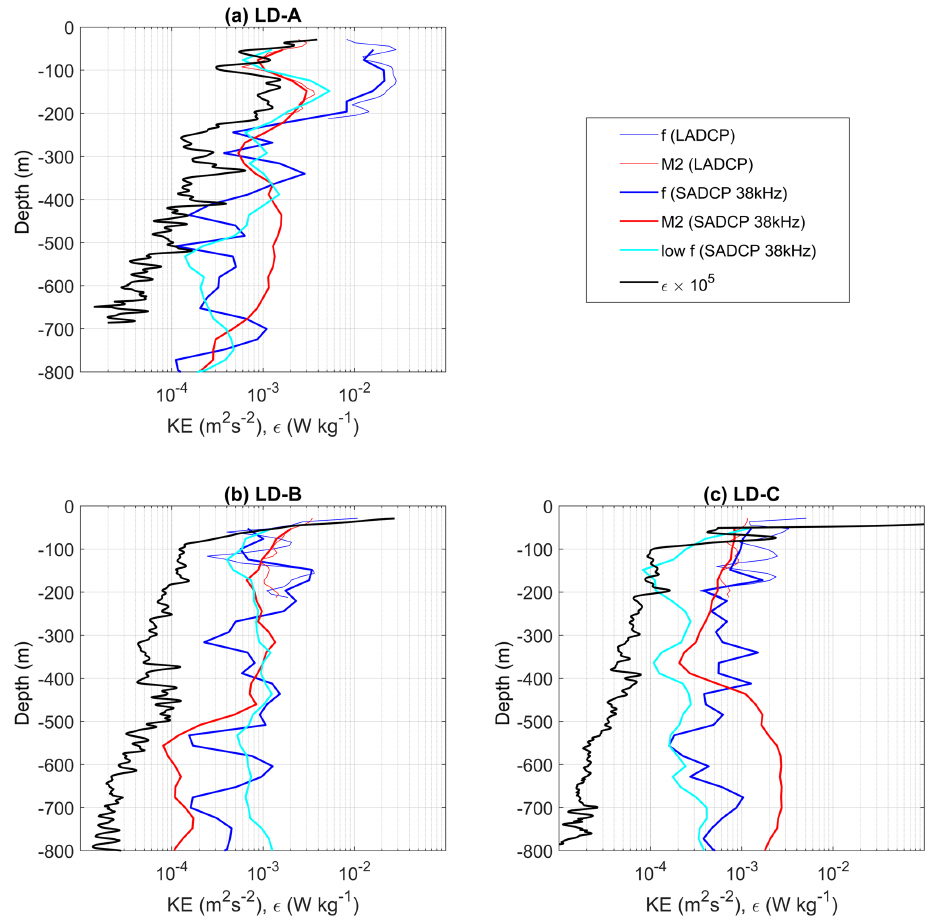
Figure 9. Time-mean profiles of the kinetic energy of the subinertial flow, the inertial and semi-diurnal frequencies, and (cid:15) at LD-A (a) , LD-B (b) , and LD-C (c) . The kinetic energy was derived from the 38kHz SADCP data but also from the 150kHz SADCP data for the inertial and semi-diurnal kinetic energies (thin blue and red